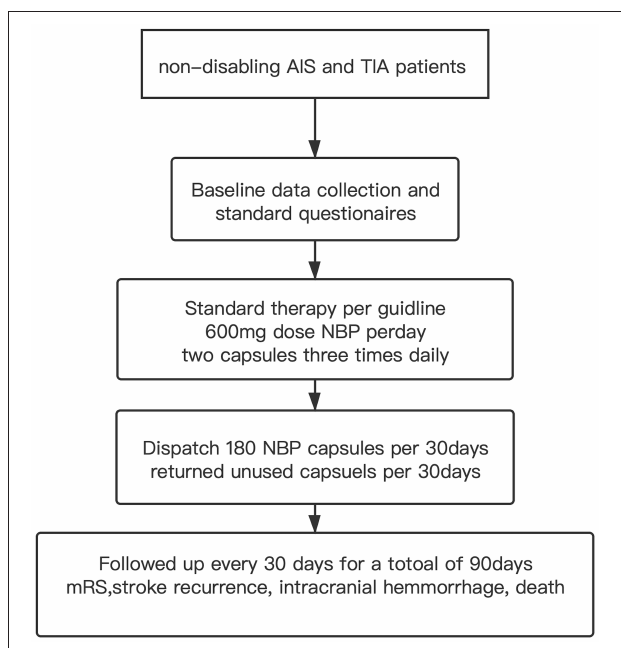
FIGURE 1 | Flow progress